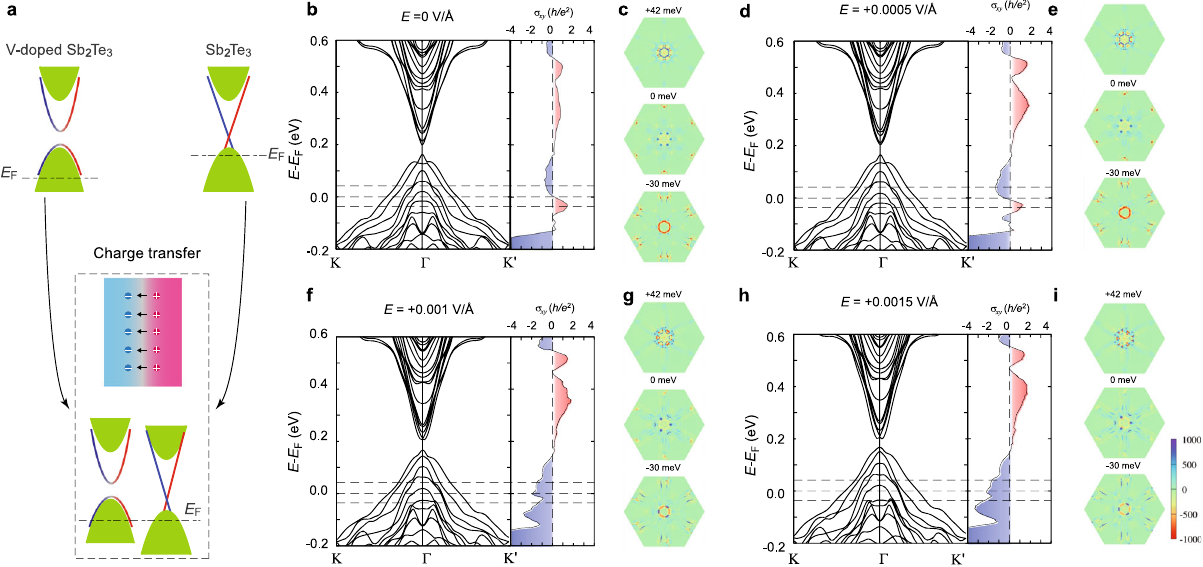
Fig. 4 Schematic of the charge transfer between the TI and magnetic TI layers and calculated band structures and Berry curvature distribution of the magnetic TI fi lms under various electric fi elds. a Schematic of the charge transfer through the interface between the Sb 2 Te 3 and V-doped Sb 2 Te 3 layers. The V-doped Sb 2 Te 3 layer has more hole carries than the Sb 2 Te 3 layer. A built-in electric fi eld is generated at the Sb 2 Te 3 /V-doped Sb 2 Te 3 interface. b , d , f , h The calculated band structures (left) and corresponding Hall conductance σ xy (right) of 5 QL Sb 1.9 V 0.1 Te 3 fi lms under electric fi eld E = 0 V/Å ( b ), E = 0.0005 V/Å ( d ), E = 0.001 V/Å ( f ), and E = 0.0015 V/Å ( h ). c , e , g , i The calculated Berry curvature distribution of 5 QL Sb fi eld E = 0 V/Å ( c ), E = 0.0005V/Å ( e ), E = 0.001 V/Å ( g ), and E = 0.0015 V/Å ( i ). The chemical potential positions are slightly shifted ( − 30 to 0 to 42 meV) to simulate the in fl uence induced by the charge transfer and/or the gating effect in